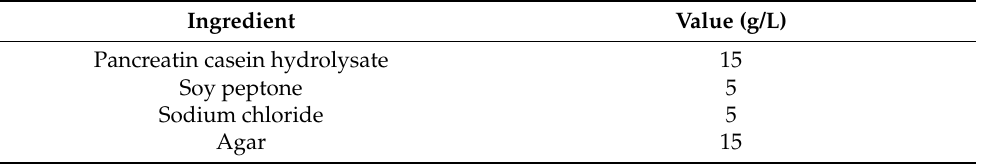
Table 2. The composition of TSA